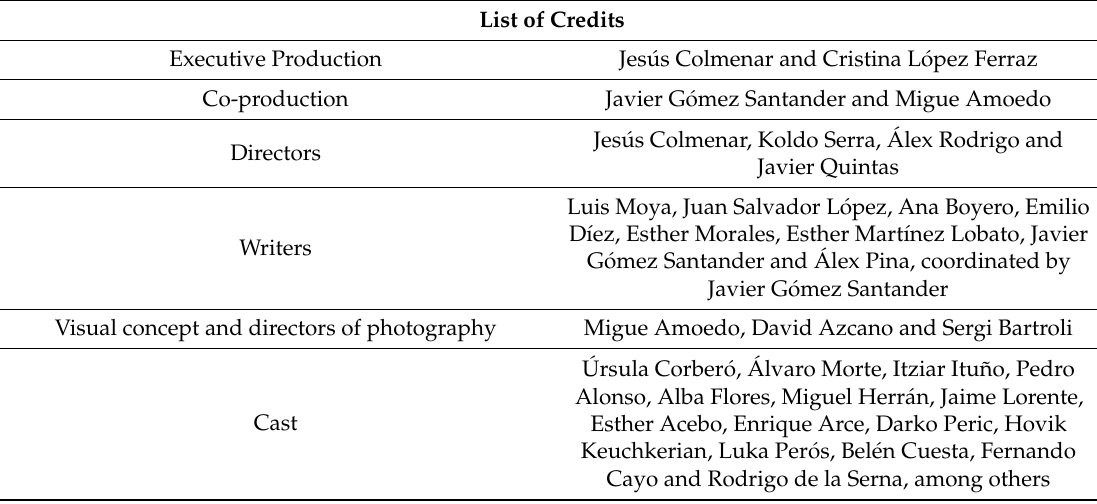
Table 1. List of credits Money